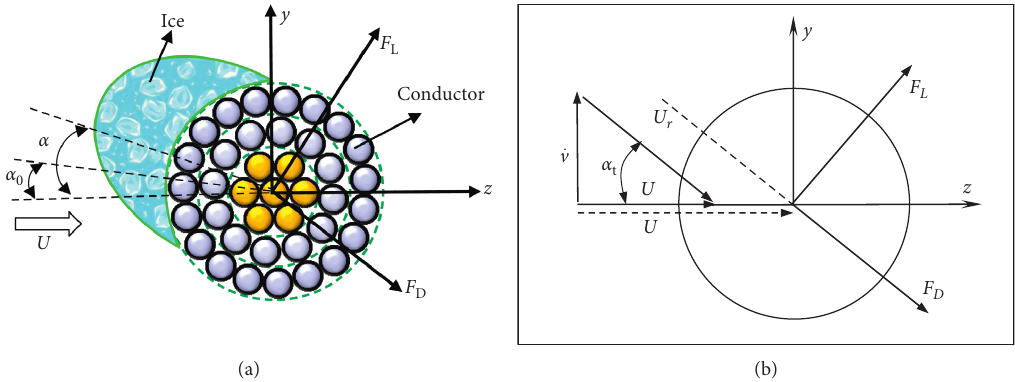
Figure 3: (a) The cross sectional model of crescent iced conductor. (b) Relative flow in the quasi-steady